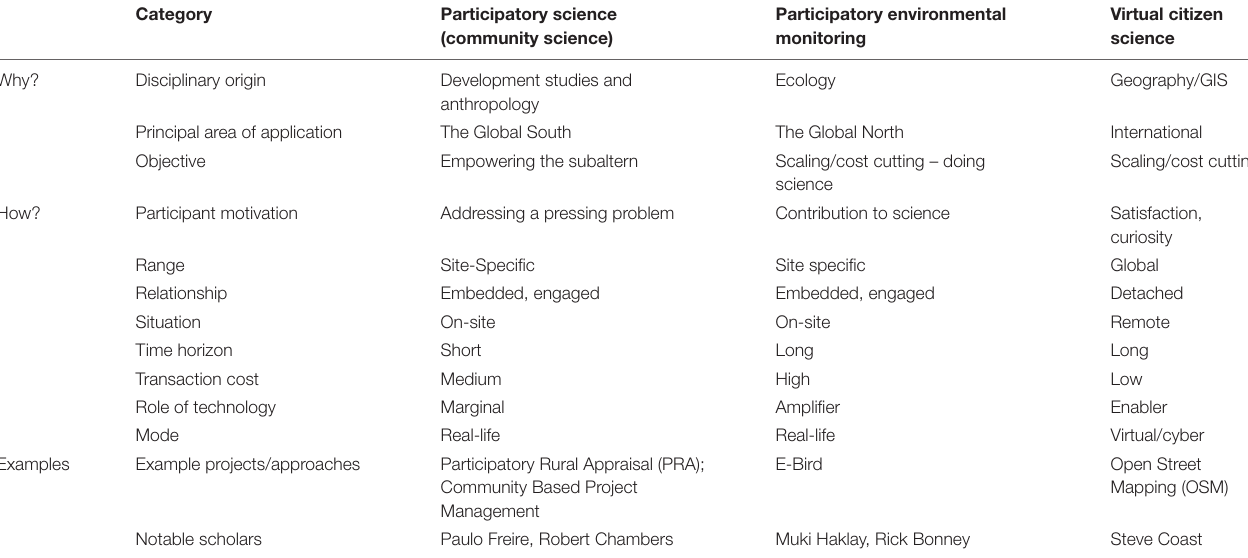
TABLE 4 | Citizen–science